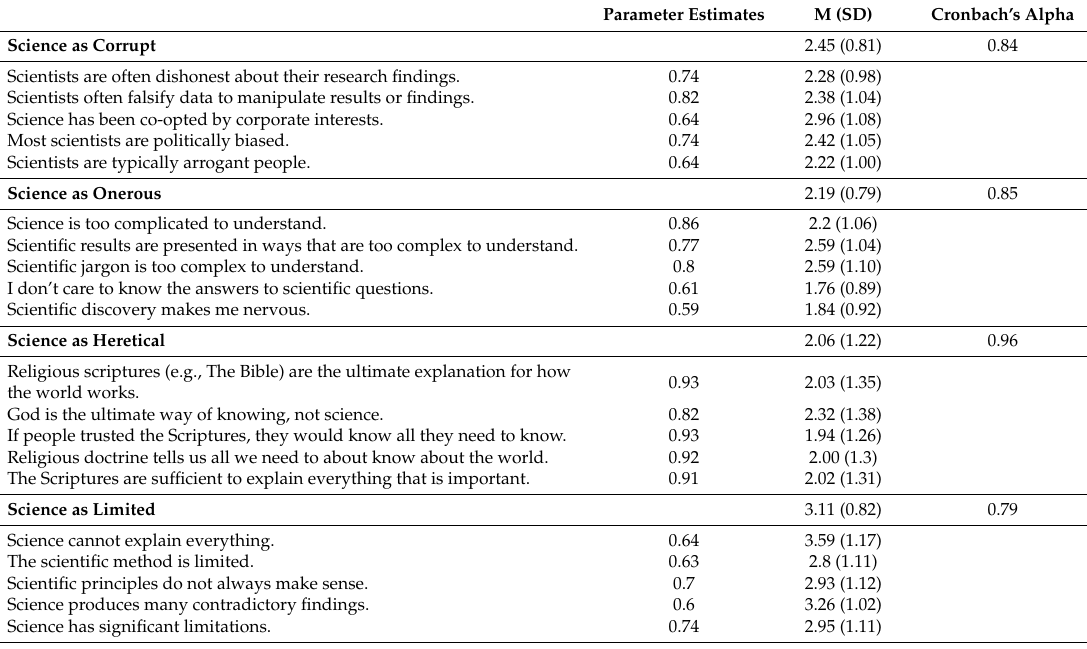
Table 4. Final NPSS Scales and Descriptive